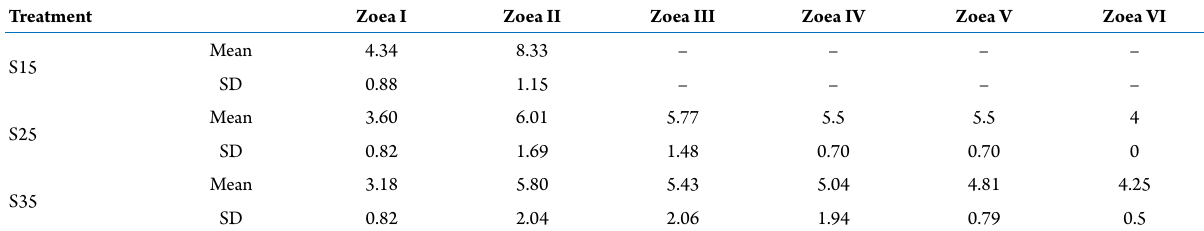
Table 3. Leptuca leptodactyla . Mean and Standard Deviation (SD) of the duration (in days) of the larval stages at the treatments S15, S25 and S35. No ZI larvae underwent to next stage at S0 or S5. Treatment